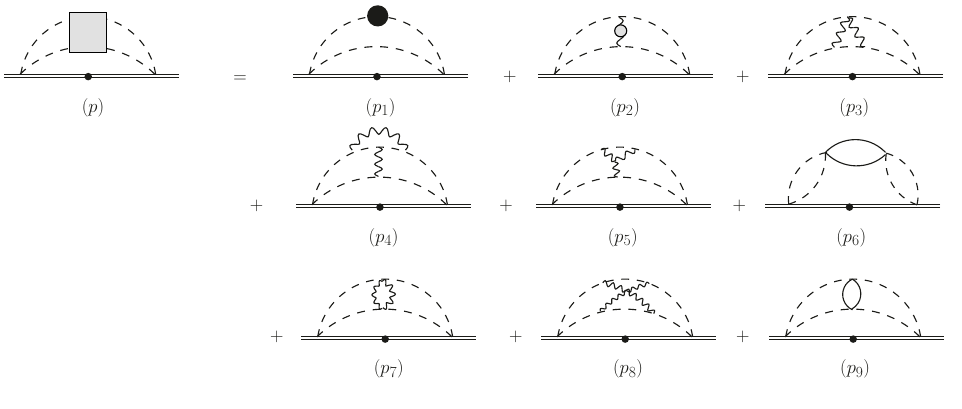
Figure 5 . Scalar bubble